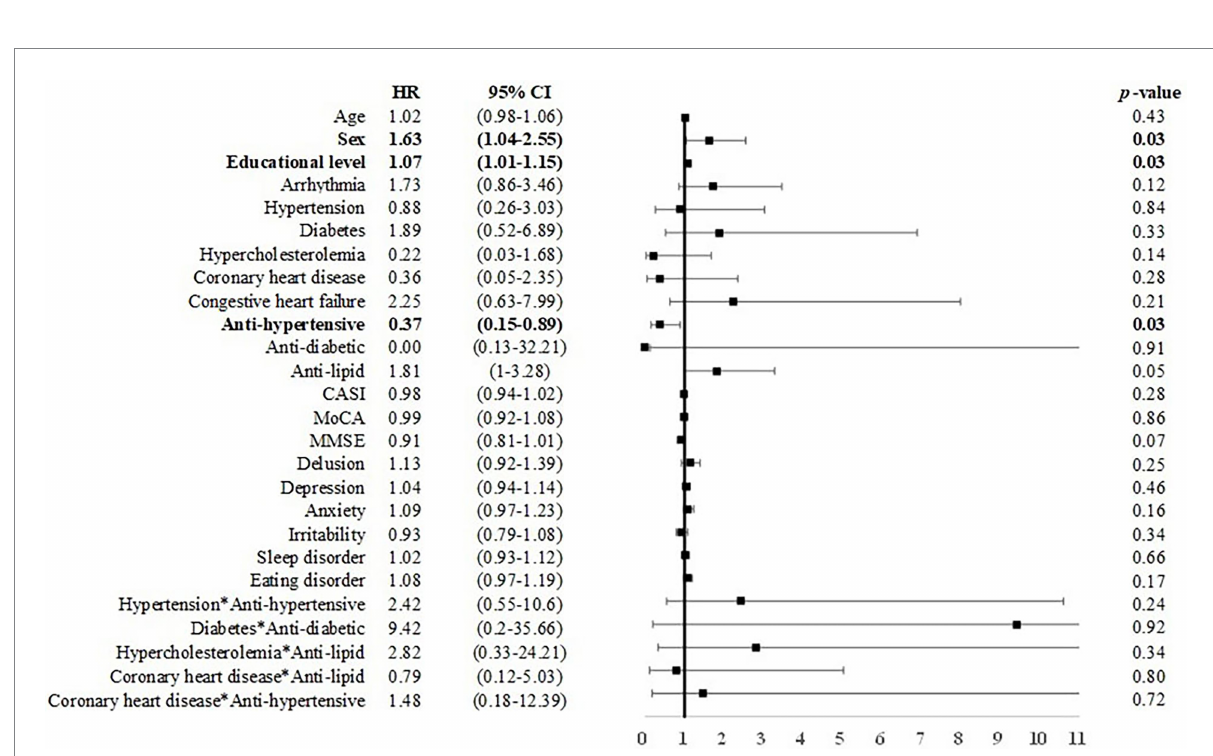
FIGURE 4 Risk of incident dementia among individuals with MCI under 75 years of age. Note and abbreviations as those used in Figure